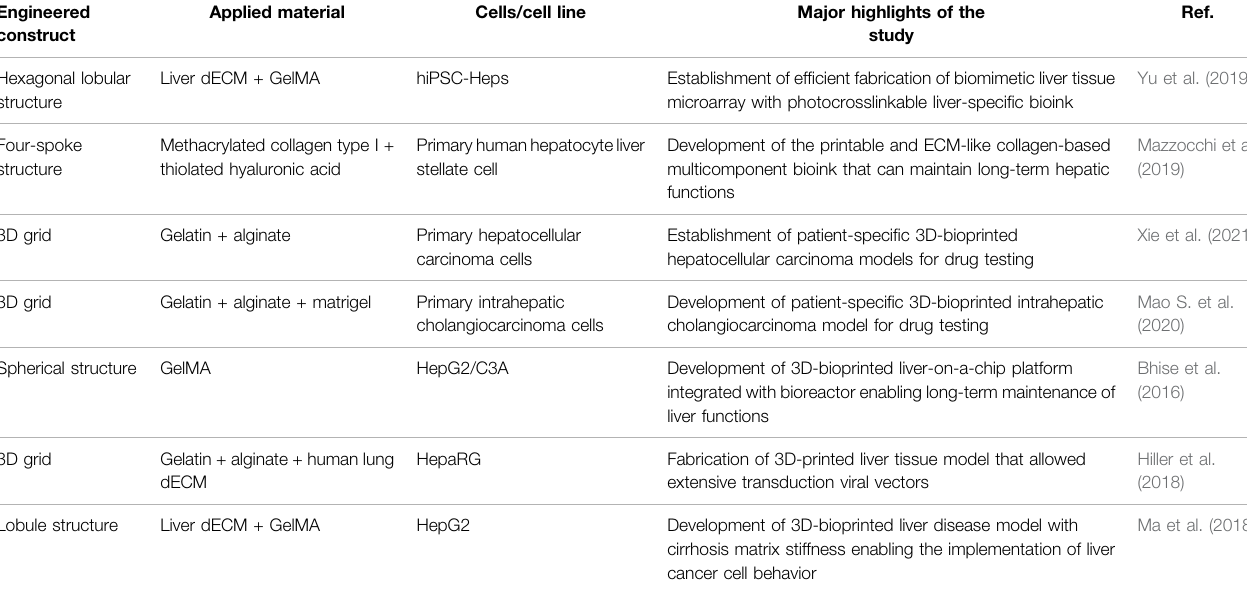
TABLE 2 | Single structure of multicomponent bioink-based 3D-printed liver tissue models for drug screening and liver disease models. Engineered